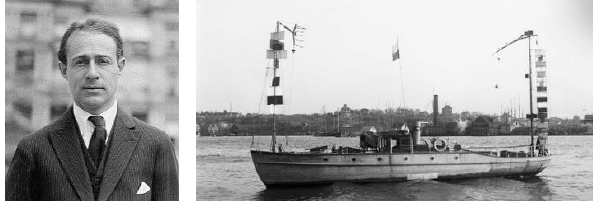
Fig. 3. John Hammond Jr. (1922) and his wireless torpedo boat “Natalie” (November 23,